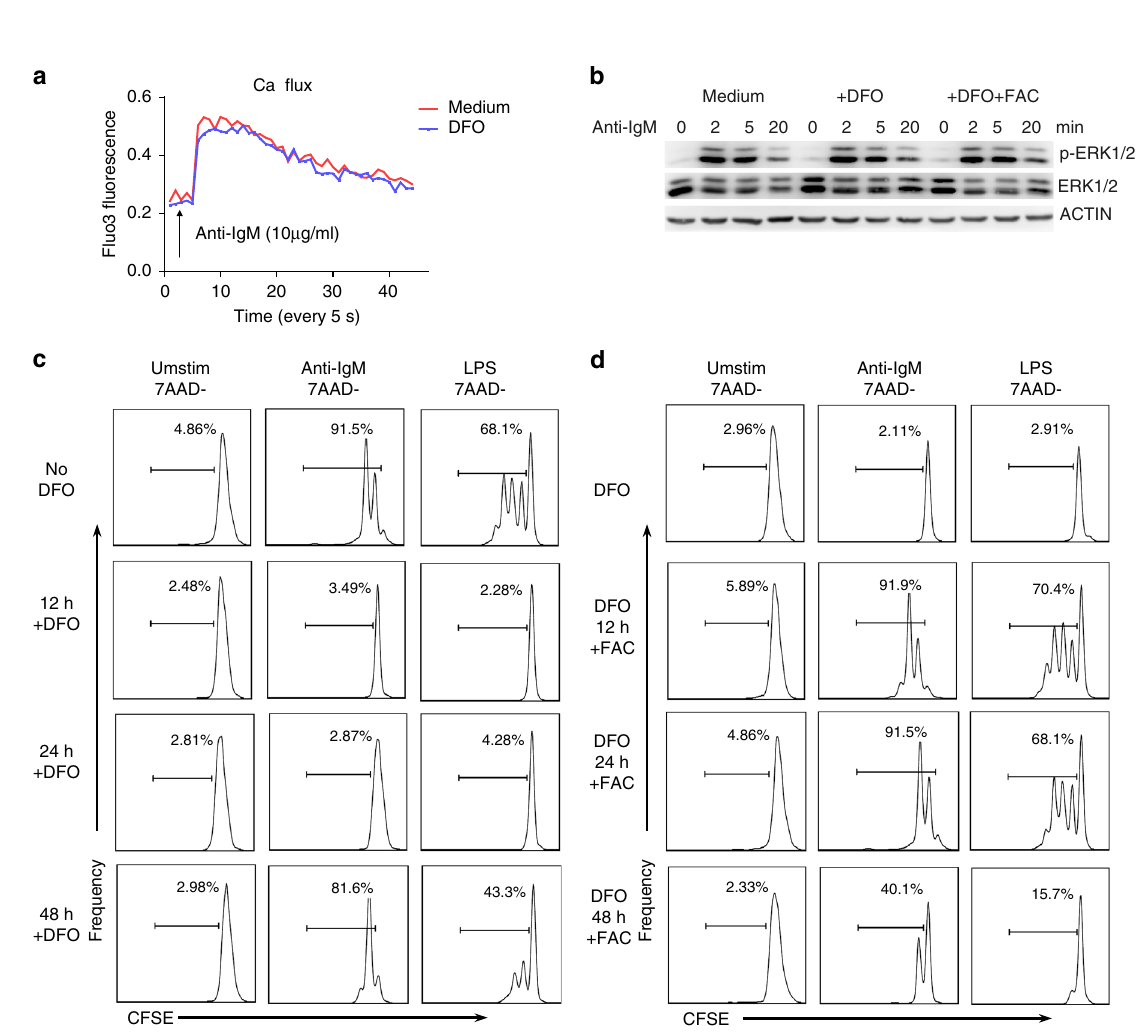
Fig. 5 Iron is essential only for the middle and late stages of BCR- and TLR-induced B-cell proliferation. a Intracellular calcium fl ux in control and iron- de fi cient (pretreated with 20 µ M DFO for 2 h) resting B cells puri fi ed from wild-type C57BL/6 splenocytes in response to BCR stimulation. b Control and iron-de fi cient (pretreated with 20 µ M DFO for 2 h) B cells were stimulated with anti-IgM (10 µ g/ml) for 0 – 20 min. At the indicated time points, the cells were immediately collected, washed, and lysed. Subsequently, the phosphorylation of ERK1/2 was measured by immunoblotting. c CFSE-labeled splenic B cells from wild-type mice were unstimulated or stimulated with anti-IgM and LPS, and cell proliferation was assessed by CFSE dilution at 72 h. During this process, DFO (20 µ M) was added to the culture medium at different time points to deplete iron. d CFSE-labeled iron-de fi cient B cells (in the presence of 20 µ M DFO) were stimulated as in c , and cell proliferation was assessed at 72 h. During this process, FAC was added to the culture medium at different time points to restore the iron supply. The data are representative of three independent Detailed analysis con fi rmed that cyclin D2 and cyclin E1 were induction of cyclin D2 occurred ~4 h post stimulation and the major isoforms associated with B-cell proliferation (Supple- remained unaffected 12, 24, and 48 h post stimulation in iron- mentary Fig. 6a). Cyclin E1 expression was markedly induced de fi cient B cells (Fig. 6c, d and Supplementary Fig. 6b, c). 24 h and 48 h after BCR or TLR stimulation in control B cells Additionally, Bcl-x L ( Bcl2l1 ) induction was intact in iron- de fi cient B cells, consistent with the results that iron was not but was severely impaired in iron-de fi cient B cells. In contrast,